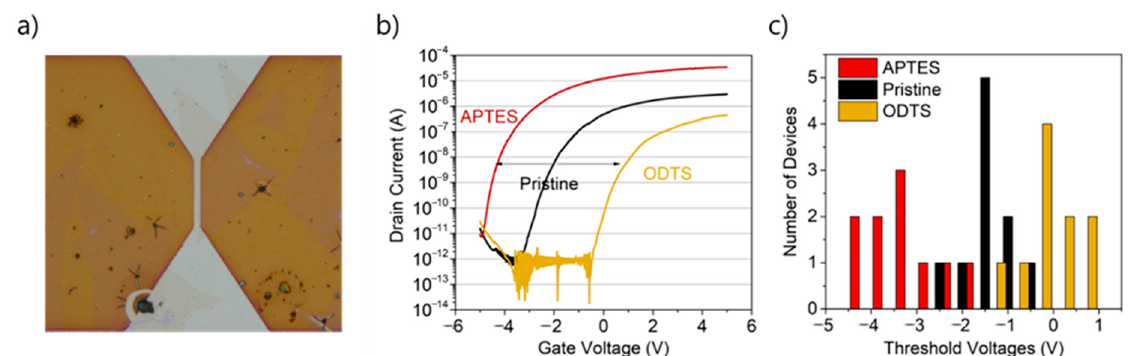
Figure 3. Effect of surface functionalization on the carrier density of the MoS 2 monolayer. ( a ) An optical image of the field effect transistors based on the MoS 2 monolayer fabricated using photolithography. ( b ) Transfer curve at 0.1 V drain-source voltage acquired from the devices. ( c ) A change in threshold voltages for 10 control devices before and after surface functionalization. Note that threshold voltages shifted toward more negative voltages for the APTES-MoS2 devices and shifted toward more positive voltages for ODTS-MoS2 devices.